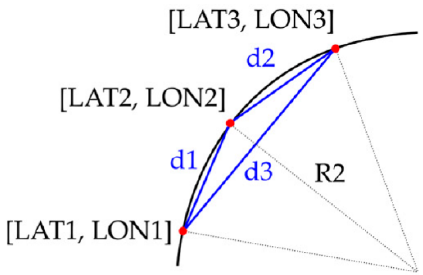
Figure 2. Turning radius R 2 from circumscribed circle of a triangle defined by three points on curve.